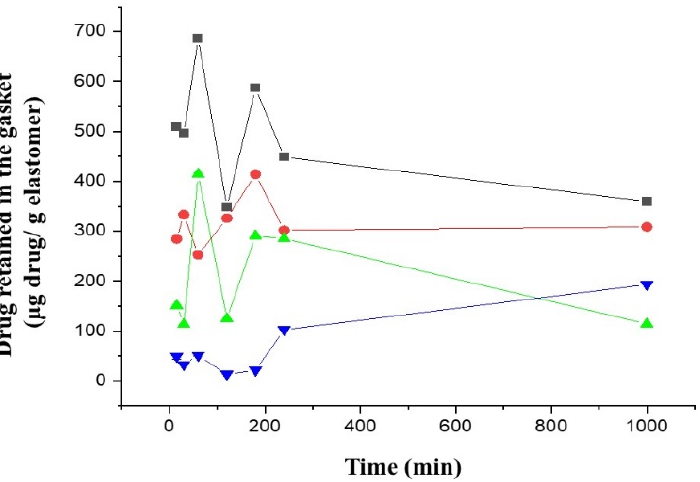
Figure 7. Adsorption of benzodiazepines on elastomeric gaskets. Key: - (cid:4) —DJEA, diazepam in sealing type PH 701/50 C BLACK; - • —DJEN, diazepam in sealing type 4023/50 GRAY; - (cid:78) —MJEA, midazolam in sealing type PH 701/50 C BLACK; and - (cid:72) —MJEN, midazolam in